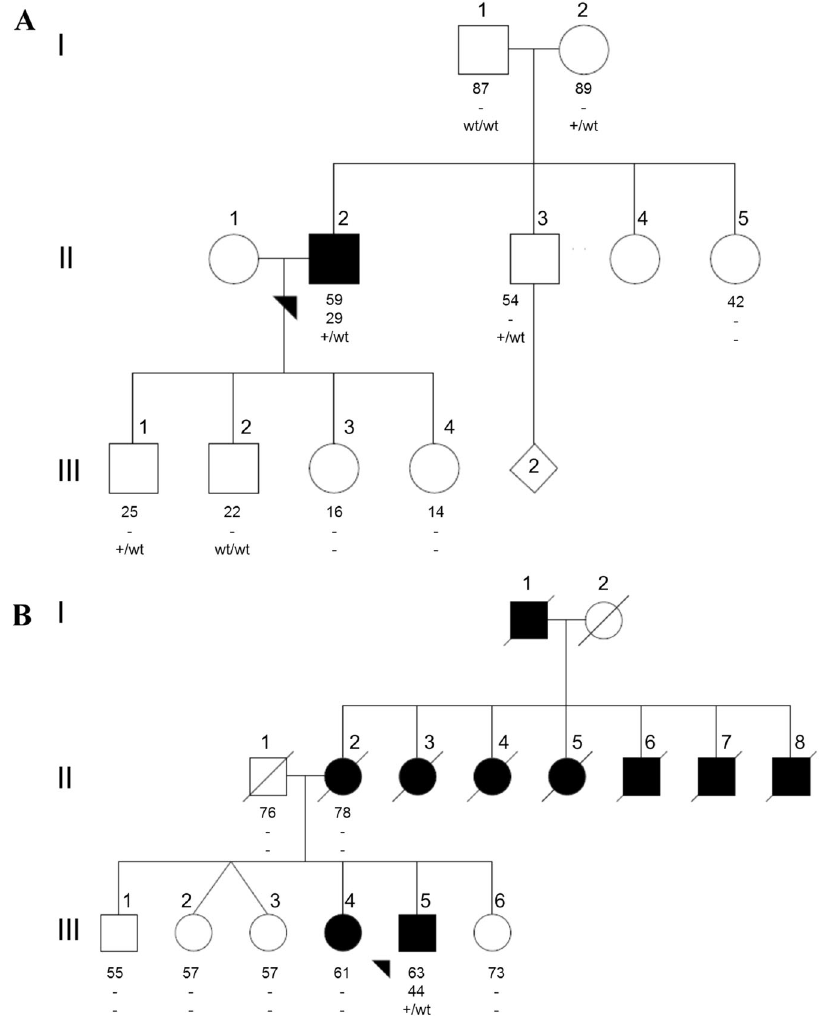
Fig. 2 Pedigree diagram of the a Peruvian p.R1441G and b Brazilian p.R1441C families. Individuals affected with Parkinson ’ s disease are represented with black symbols, unaffected individuals with open symbols. Age at last clinical evaluation (or age at death if individual is deceased) is indicated immediately below each symbol, followed by age at onset; +, mutation carrier; wt,